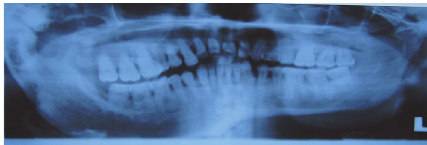
Figure 4: OPG reveals diffuse enlargement of skeletal and dental hard tissue enlargement on right side of the face.